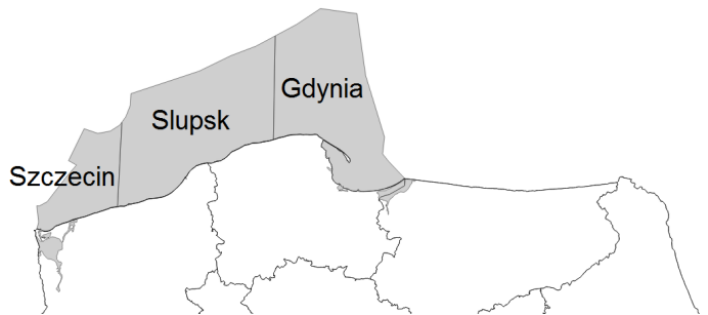
Figure 4. Territorial scope of the Maritime Offices. Source: prepared by the author based on State Register of Borders.